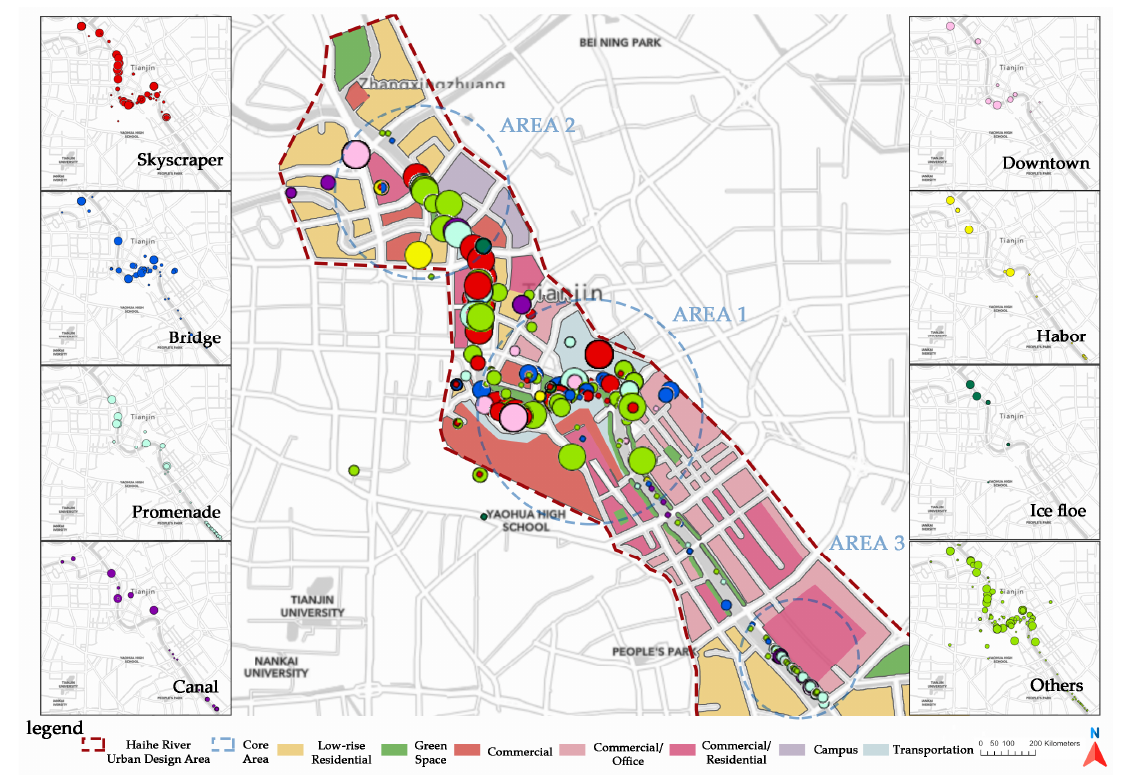
Figure 12. Spatial analysis of image classification TOP-1 results and current development land uses.